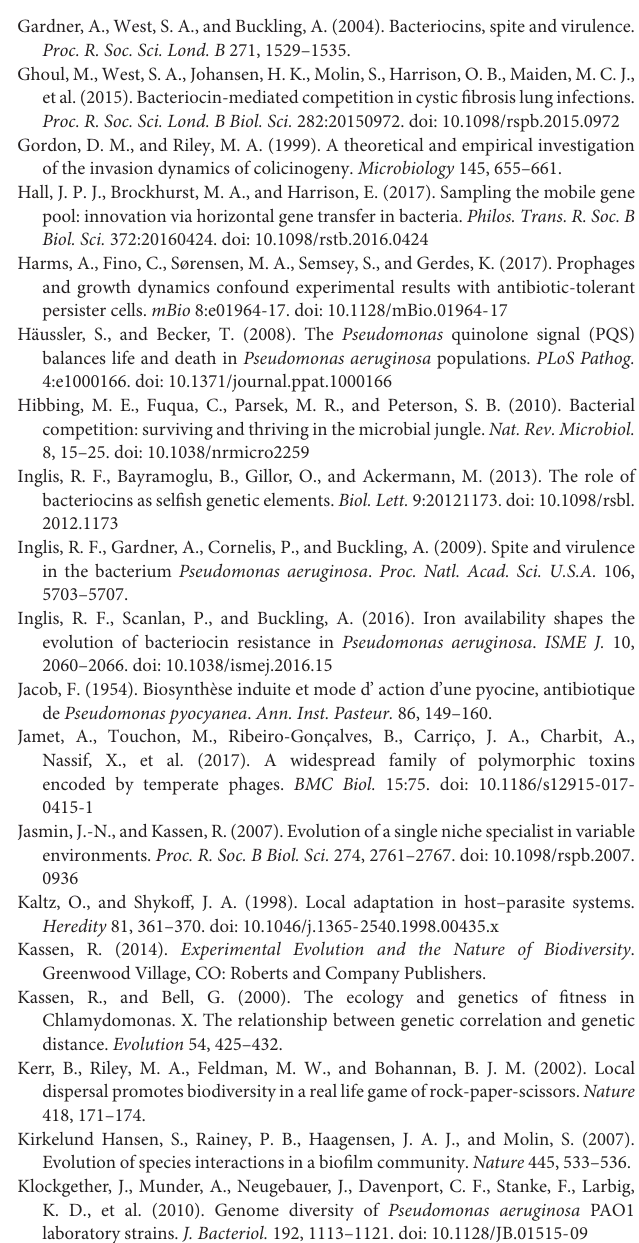
Supplementary Table 1 | SNPs and small indels in evolved populations. Supplementary Table 2 | Copy number variants in evolved